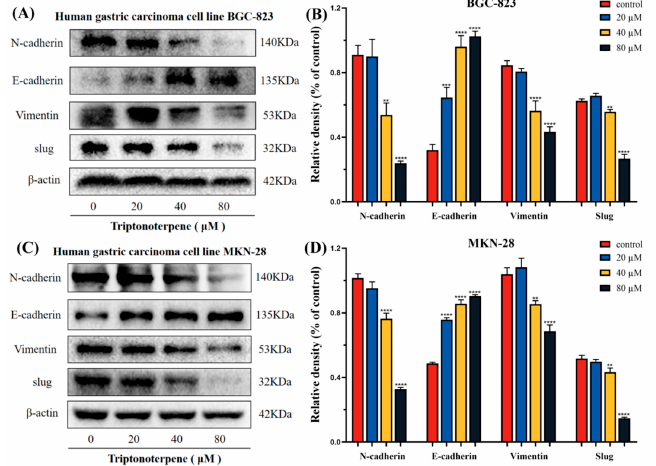
Figure 7. The expression levels of the EMT ‐ related proteins in the GC cells was detected using Western blots. ( A , B ) Expression levels of N ‐ cadherin, E ‐ cadherin, Vimentin, and Slug in the BGC ‐ 823 cells. ( C , D ) Expression levels of N ‐ cadherin, E ‐ cadherin, Vimentin, and Slug in the MKN ‐ 28 cells. ** p < 0.01 and **** p < 0.0001. 2.8. Triptonoterpene Affects the Expression of the MMP ‐ Related Proteins in the Gastric Cancer Cells We also examined the effects of Triptonoterpene on the expression of the key proteins of MMPs. The experimental results show that the expression of MMP ‐ 9, MMP ‐ 2, and Timp ‐ 1 of the Triptonoterpene group were reduced in the BGC ‐ 823 and MKN ‐ 28 cells (Figure 8). This shows that Triptonoterpene can inhibit the expression of key proteins of MMPs to prevent the degradation of ECM.